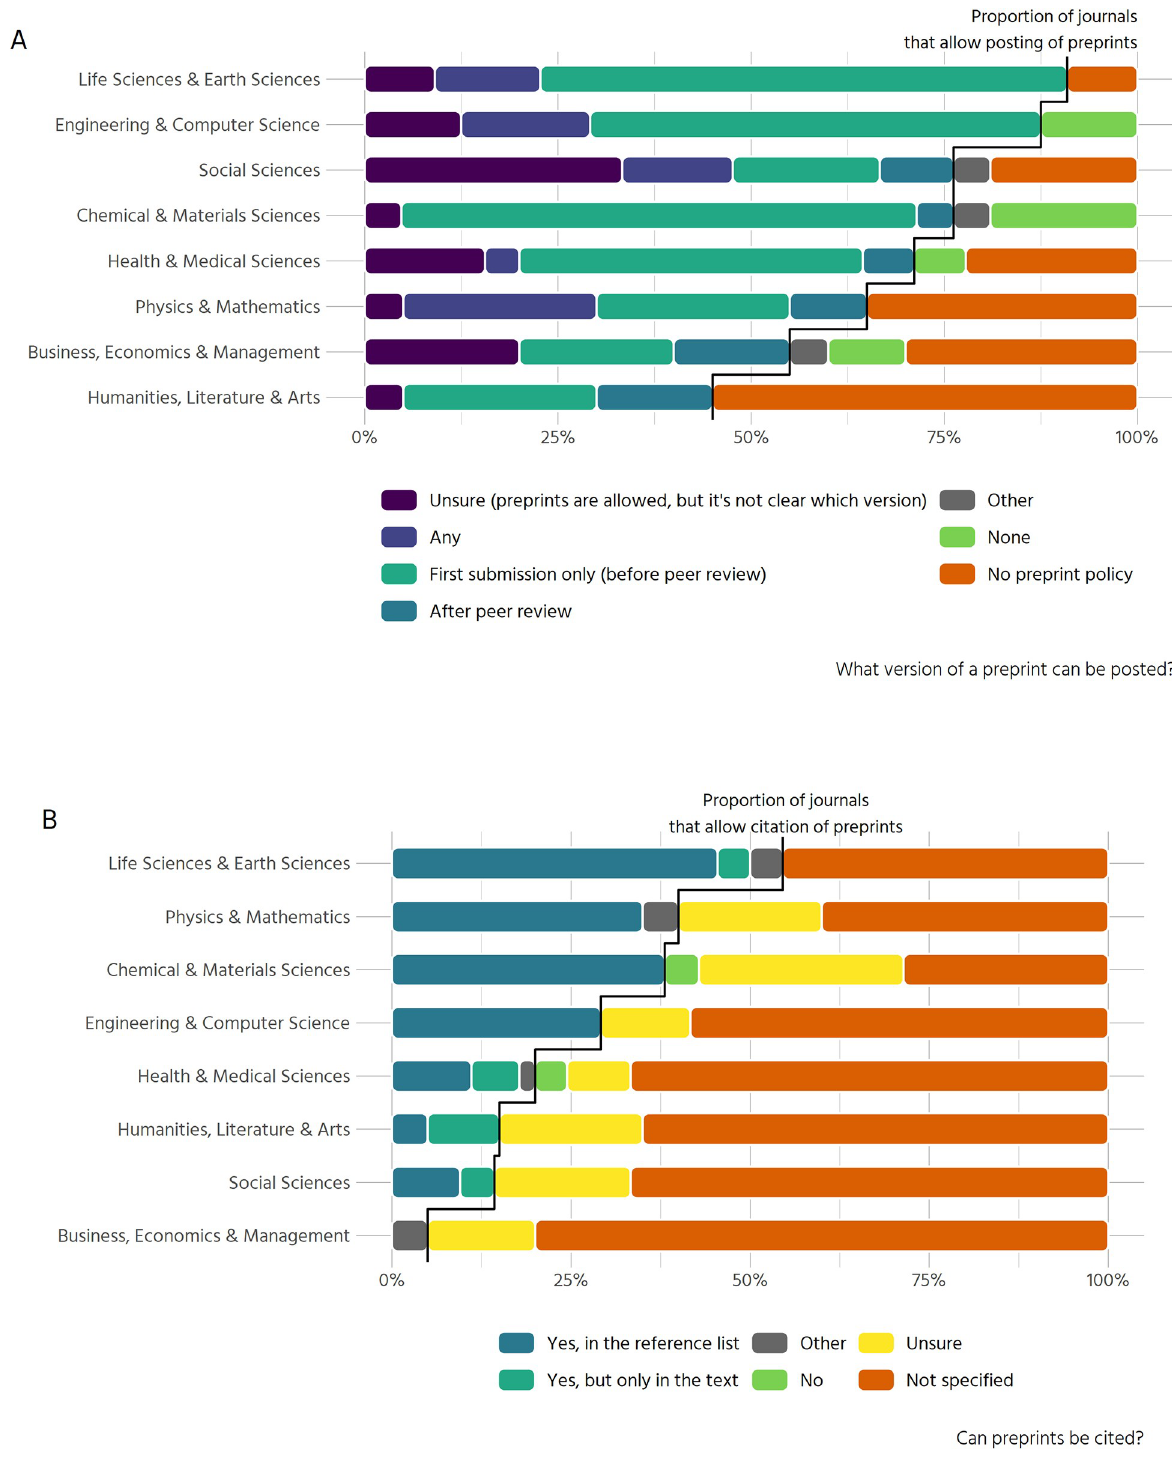
Fig 6. Posting and citing of preprints. (A) Results on whether a preprint can be posted, and which version is allowed (n = 193). (B) Results on whether preprints can be cited (n = 193).